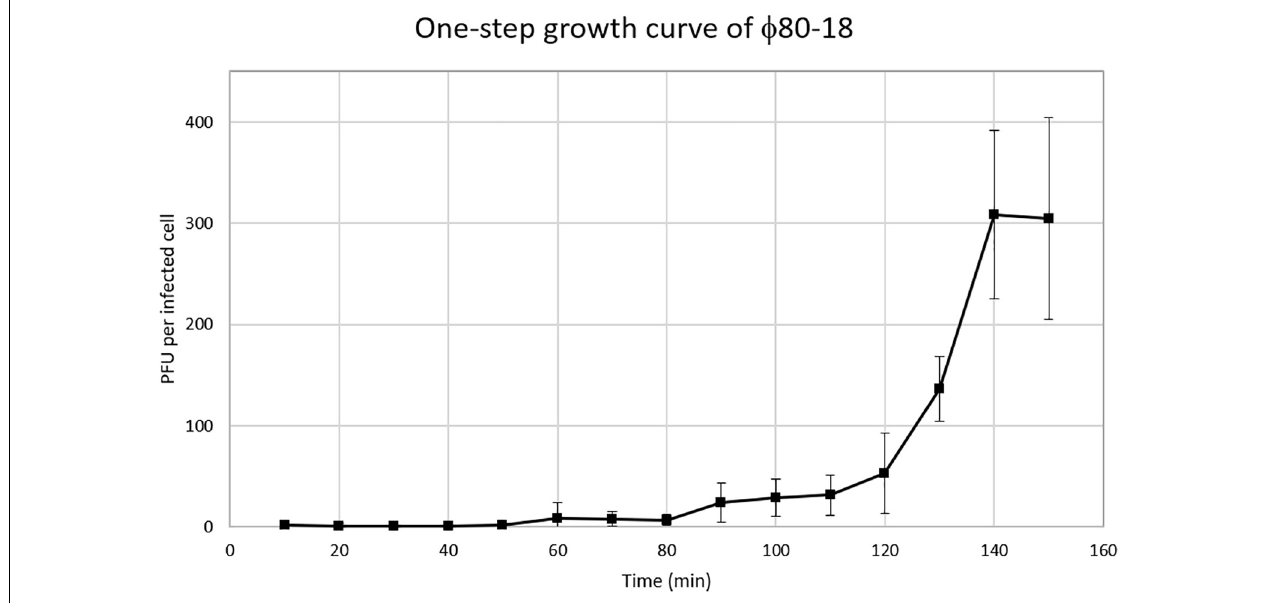
FIGURE 5 | One-step growth curve of bacteriophage φ 80-18.